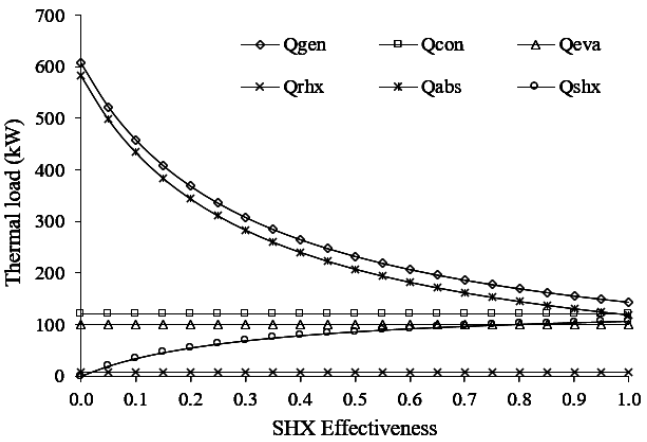
Figure 30. Effect of ε SHX on components’ thermal loads.